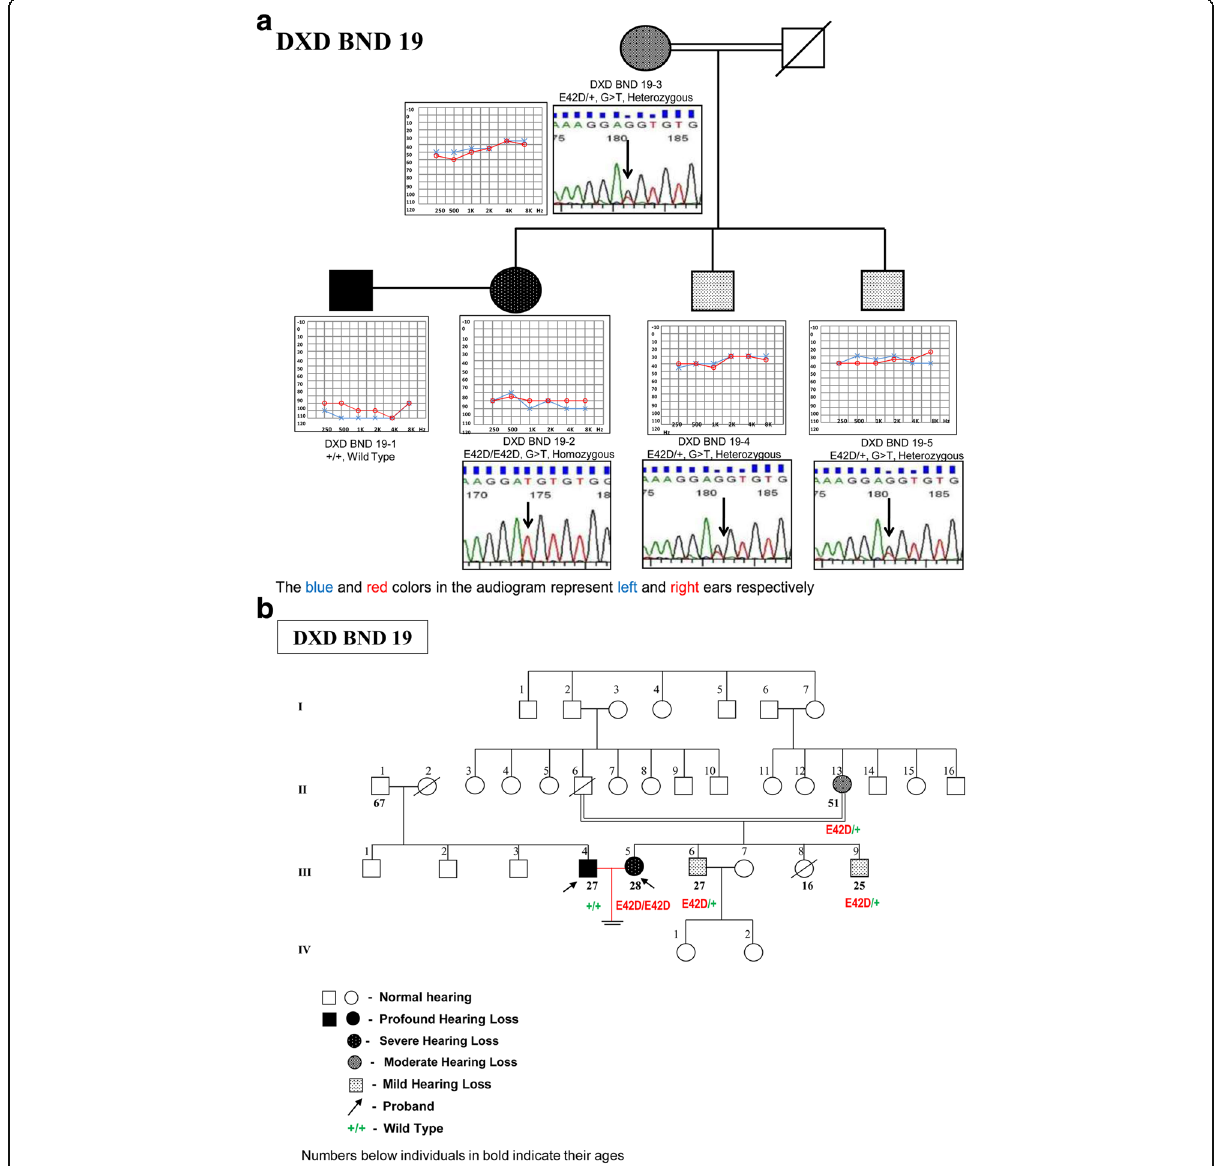
Fig. 2 a Genotype-Phenotype correlation in DXD BND 19 family with novel GJB2 mutation. b Pedigree of DXD BND 19 family showing novel mutation p.E42D in GJB2